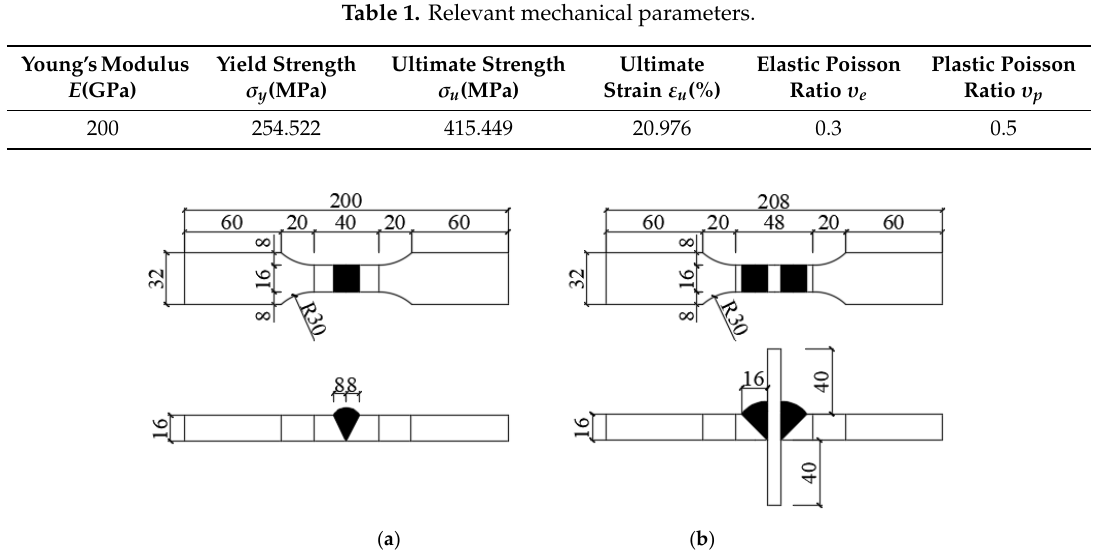
Table 1. Relevant mechanical parameters.